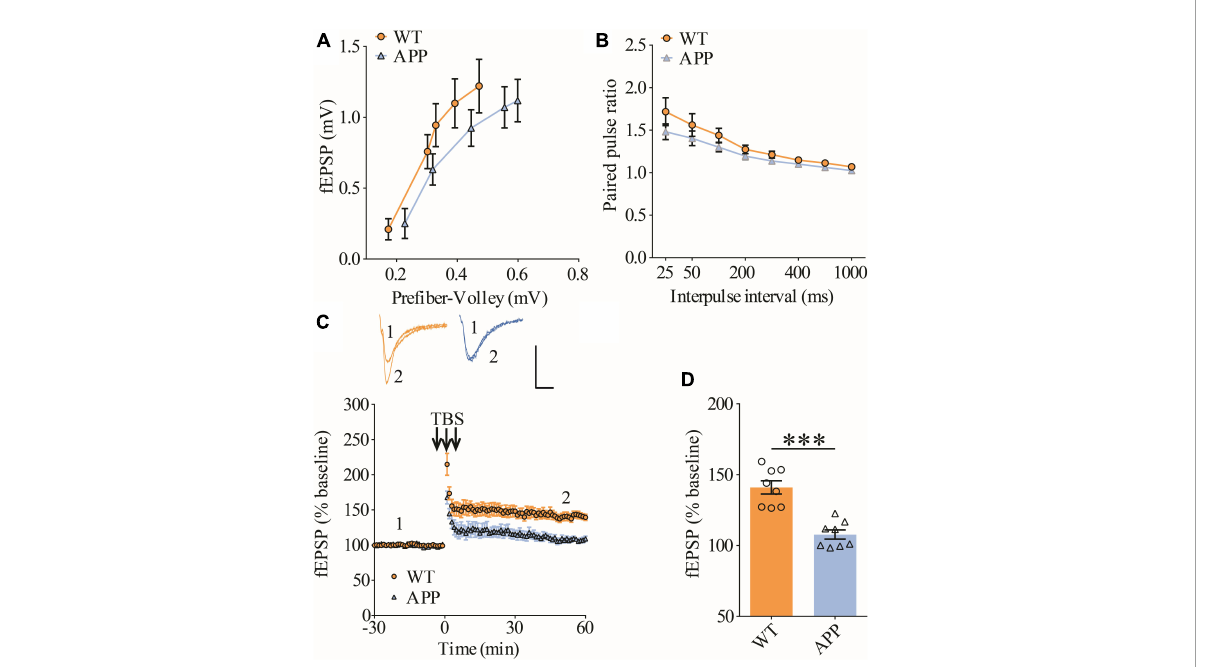
FIGURE1 Impaired LTP in ventral hippocampus in APP mice. (A) Input output curves of fEPSP showing no differences between WT and APP mice (WT: n = 9 slices from 5 mice, APP: n = 5 slices from 5 mice; genotype: F ( 1 , 12 ) = 0.060, p = 0.811; prefiber volley: F ( 4 , 48 ) = 37.27, p < 0.001; repeated two-way ANOVA). (B) Paired pulse ratio showing no differences between WT and APP mice (WT: n = 8 slices from 5 mice, APP: n = 7 slices from 5 mice; genotype: F ( 1 , 13 ) = 1.658, p = 0.220; inter-pulse interval: F ( 7 , 91 ) = 33.74, p < 0.001; repeated two-way ANOVA). (C) TBS induced LTP at the CA1 synapse in WT and APP mice. Scale bars: 0.4 mV/10 ms. (D) Summary graph of last 10 min of recording showing impaired LTP in APP compared to WT mice (WT: n = 8 slices from 5 mice, APP: n = 8 slices from 5 mice, p < 0.001, two-tailed t -test). *** P < 0 .